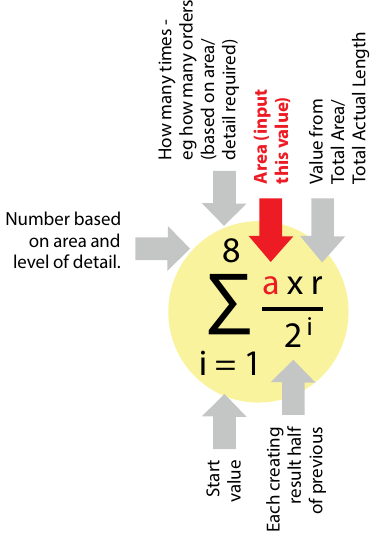
Actual Length Predicted Length